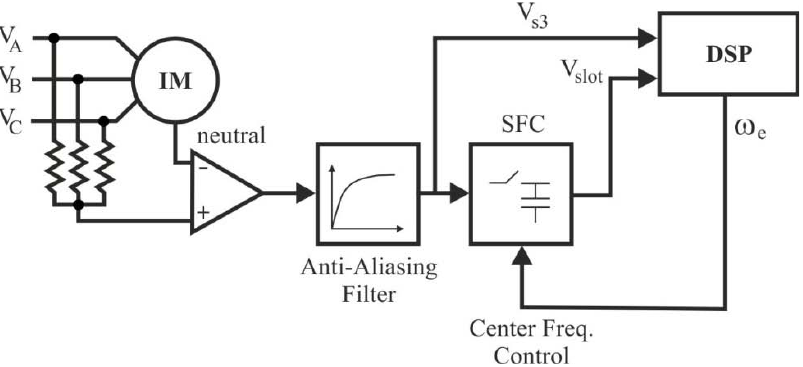
Figure 22. DSP and analog interface used to detect the stator phase voltages sum and the rotor slot harmonic component